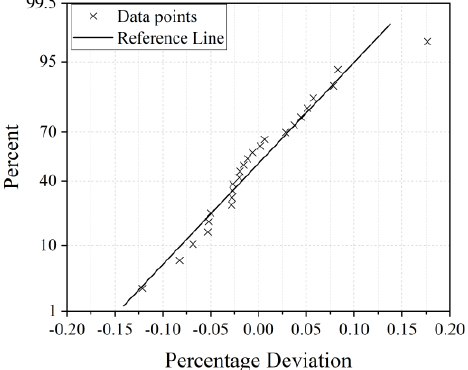
Figure 13. Normal probability plot of the percentage deviation of the model’s data and the experi- mental values.